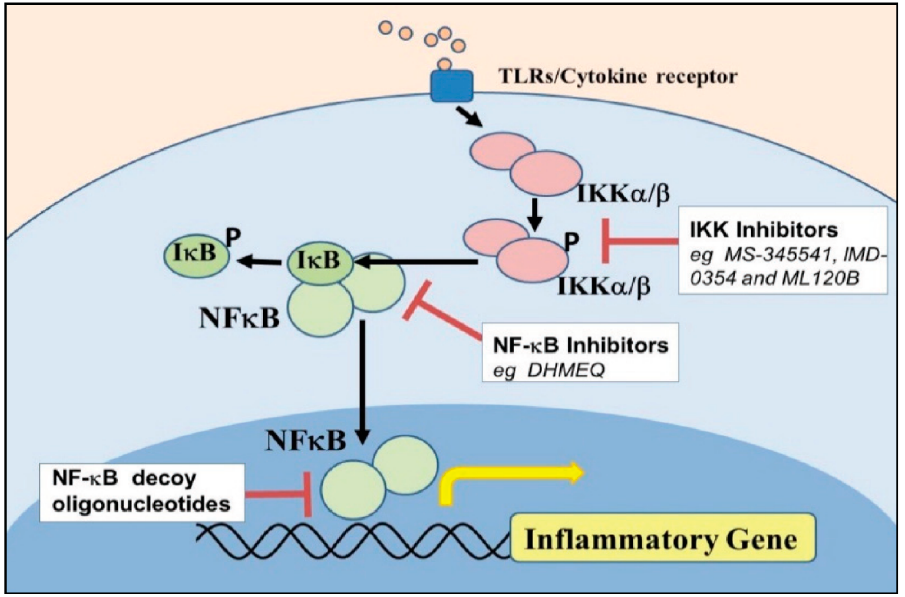
Figure 3. Schematic diagram narrating the potential cascade of NF– κ Band IKK αβ inhibitors to protect inflammatory gene.Table 88. Myeloid Differentiation factor 88.